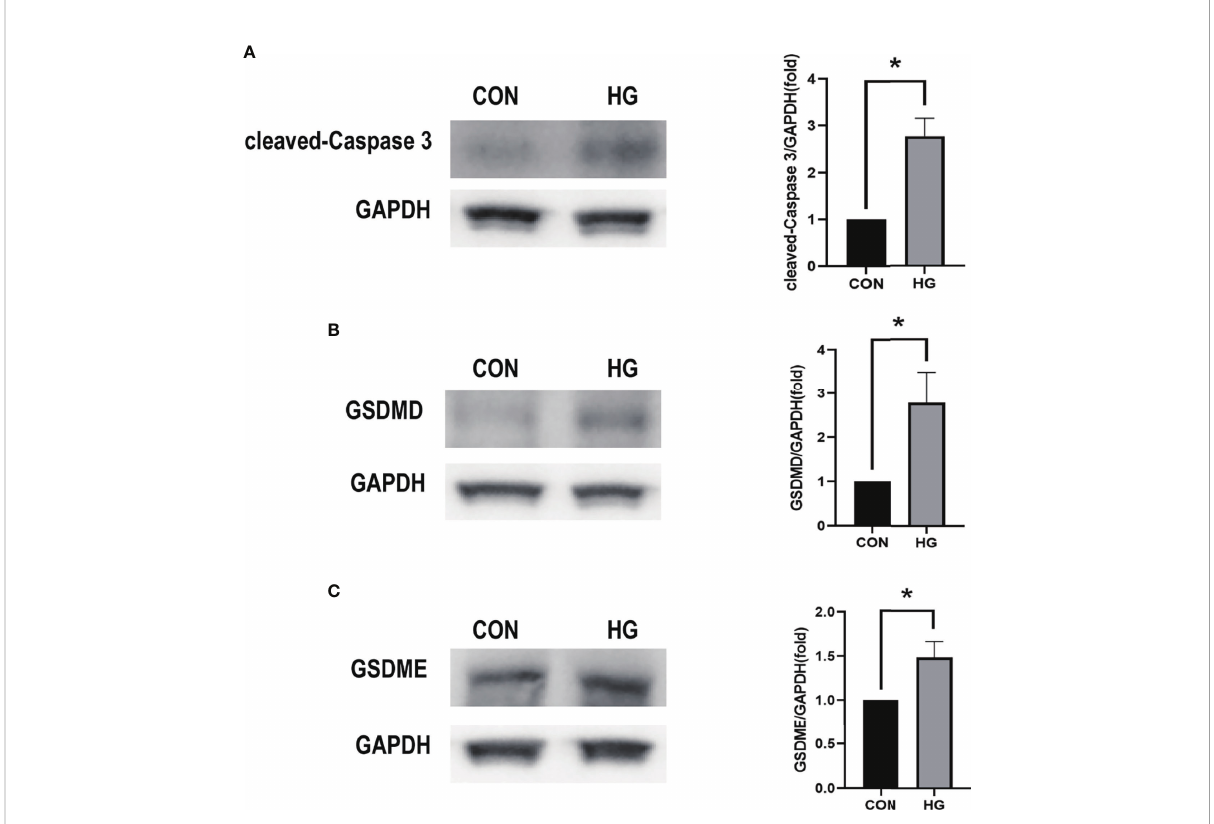
FIGURE 9 Western blot analysis of caspase-3 and gasdermin proteins in in vitro models. (A) Cleaved caspase-3 (17 kDa) was tested. GAPDH (36 kDa) was used as a control. (B) GSDMD (31 kDa) was examined. GAPDH was used as a control. (C) GSDME (55 kDa) was examined. GAPDH was used as a